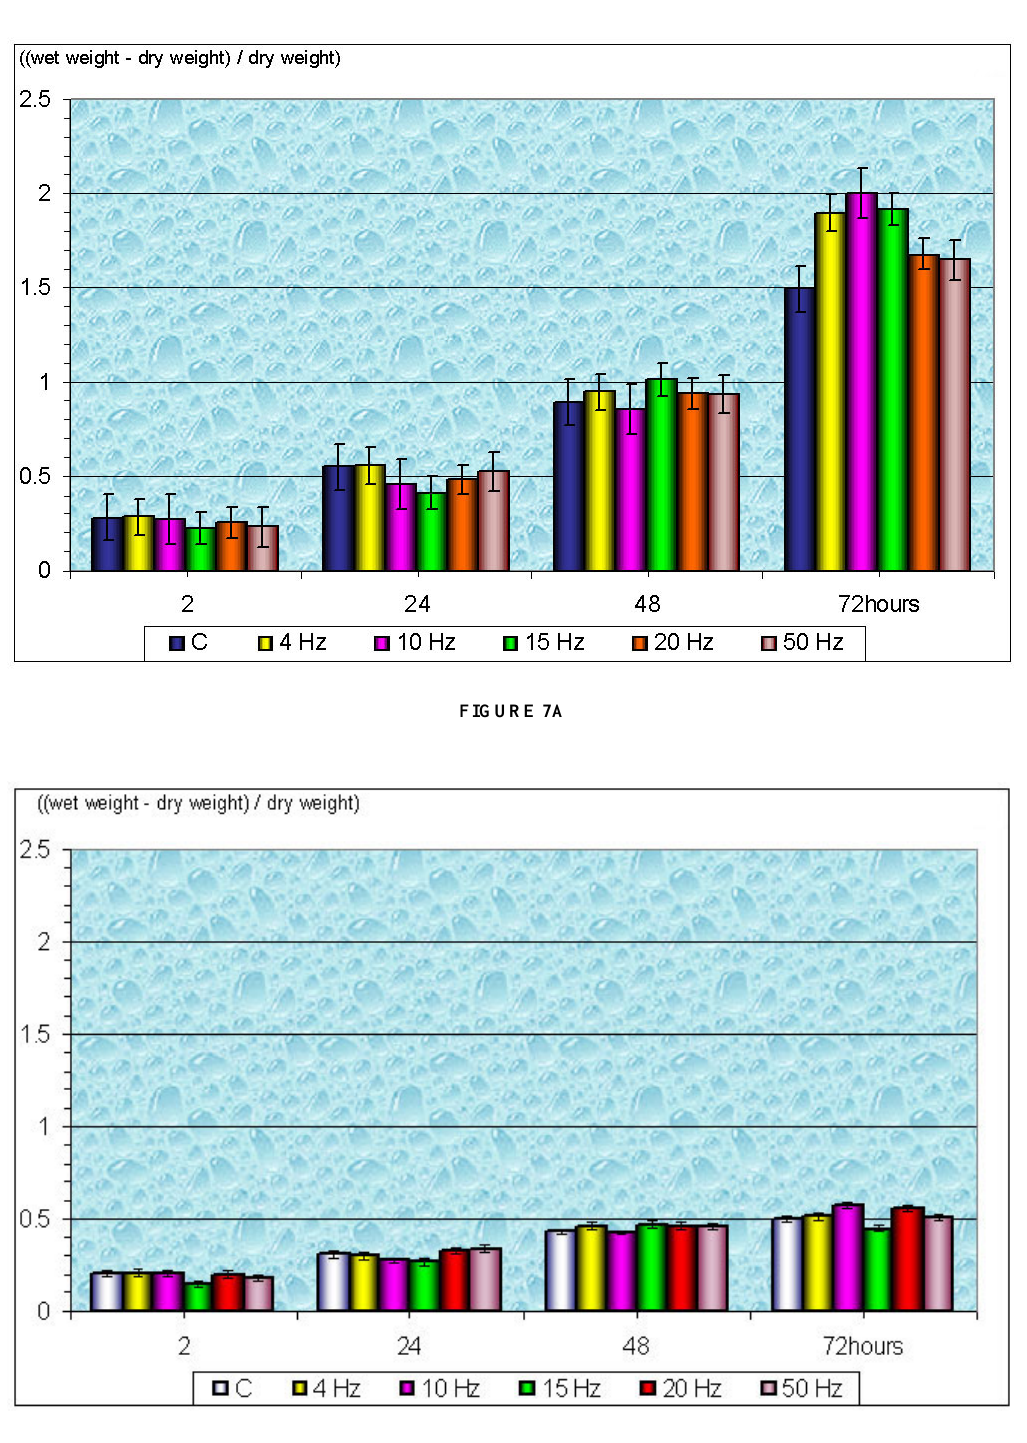
FIGURE 7. The effect of nontreated (control) and ELFV-pretreated DW on seed hydration during 72-h incubation. (A) Seed hydration at room temperature (20 o C), (B) seed hydration in cold (4 o C) DW. On abscissa, the time (in hours) of seed incubation; on ordinates, value of seeds hydration (mg of H 2 O for 1 mg of dry